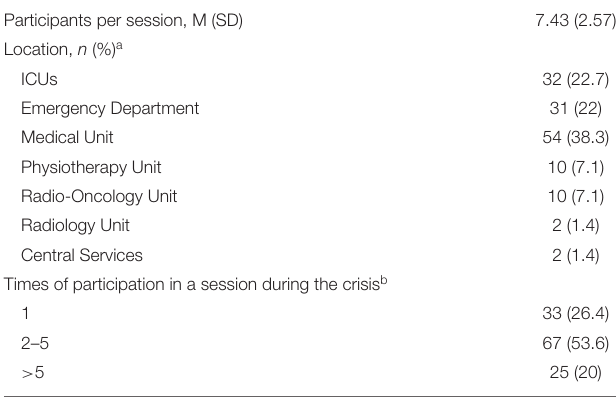
TABLE 3 | Characteristics of the